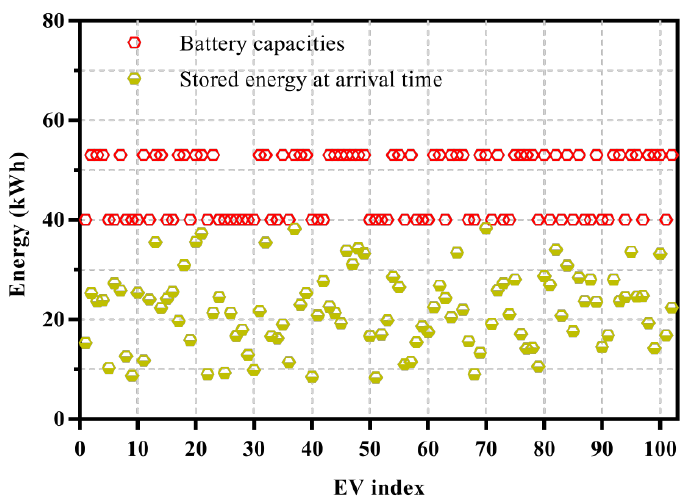
Figure 11. Arrival time state-of-charge ( SoC ) distribution against each type of battery